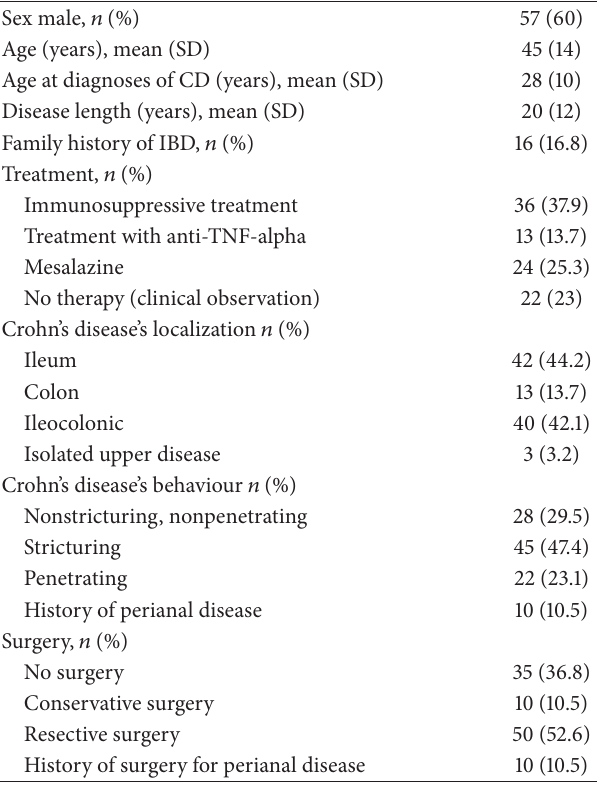
Table 1: Demographic and clinical features of patients included in the study.